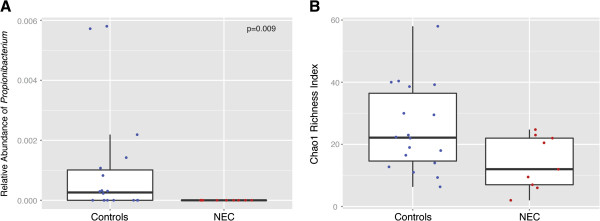
Microbial community differences between NEC and control infants, days 4 to 9 samples. (A) This box plot indicates the relative abundance of the genus Propionibacterium in 18 control samples and 9 samples prior to NEC onset during days 4 to 9 of life. None of the infants who later developed NEC, but 10 (56%) of the control samples had detectable amounts of Propionibacterium (using Fisher’s exact test for the presence or absence in NEC vs control samples, P = 0.009). (B) This box plot indicates the Chao1 richness index in samples from days 4 to 9 of life. NEC cases tended towards lower diversity than controls, but the comparison was not significant (Kruskal–Wallis, P = 0.086). For each box plot, the middle bar represents the median, the outer horizontal lines of the box represent the 25th and 75th percentiles. The dots overlaying the plots indicate the values of individual samples. Dots are distributed horizontally in order to prevent overlapping. NEC: necrotizing enterocolitis.